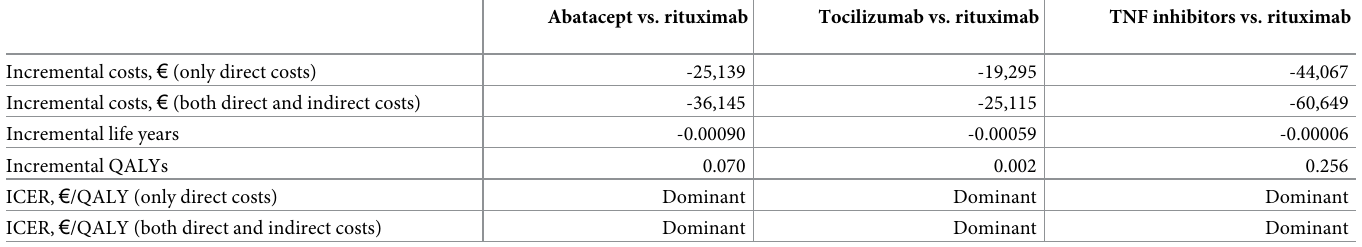
Table 3. Lifetime cost-effectiveness of bDMARDS in comparison to rituximab as a second-line biologic therapy in rheumatoid arthritis. All costs and QALYs were discounted at 3% per